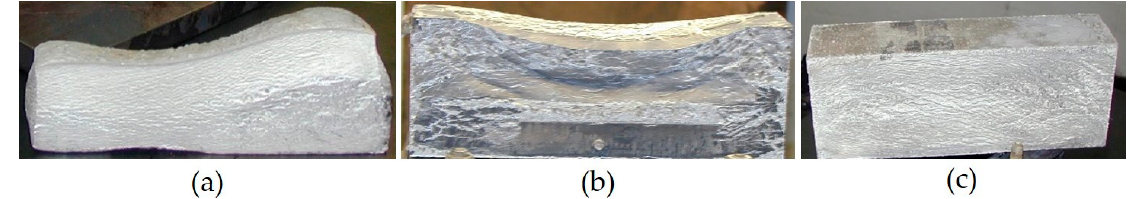
Figure 3. Rejected foam parts using a steel mold (200 × 80 × 50 mm 3 ) due to no filling the cavity of the mold ( a ) and collapsed foam ( b ) and foam block with properly adjusted parameters ( c ).